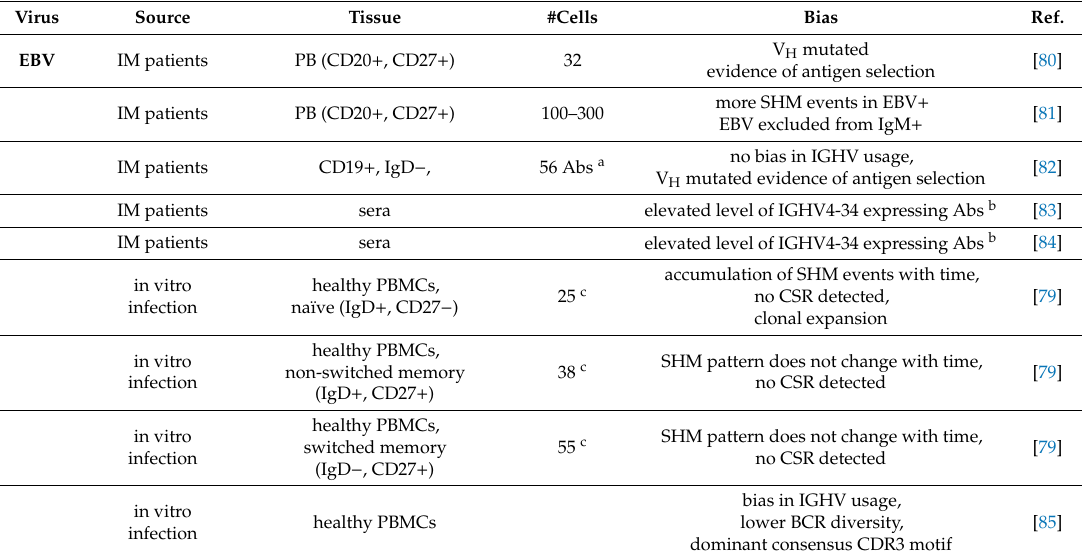
Table 1. B cell repertoire of non-transformed GHV-infected